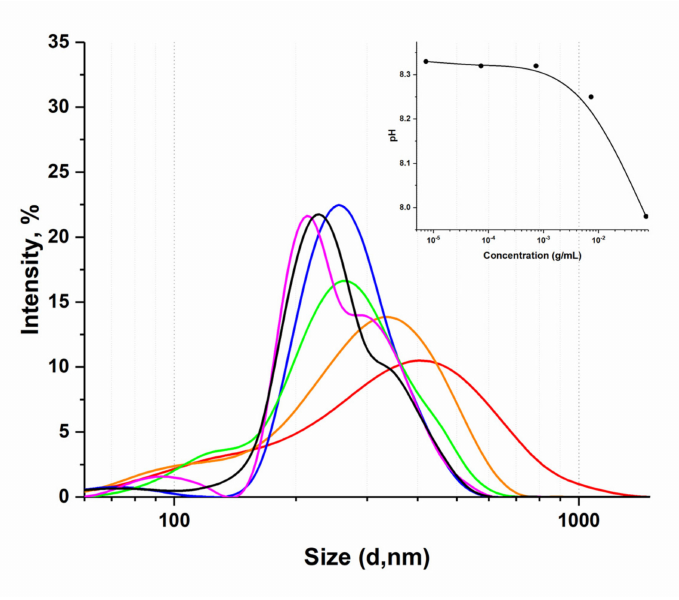
Figure 1. Particle size distribution in nano dispersion of HC dilutions ( v / v ): red—1:500 (14.7 × 10 − 3 g/mL); orange—1:1000 (7.34 × 10 − 3 g/mL); blue—1:1500; green—1:2000 (3.67 × 10 − 3 g/mL); black—1:2500 (2.94 × 10 − 3 g/mL); purple—1:3000 (2.45 × 10 − 3 g/mL); pH dependance on concentration (g/mL) is shown in the